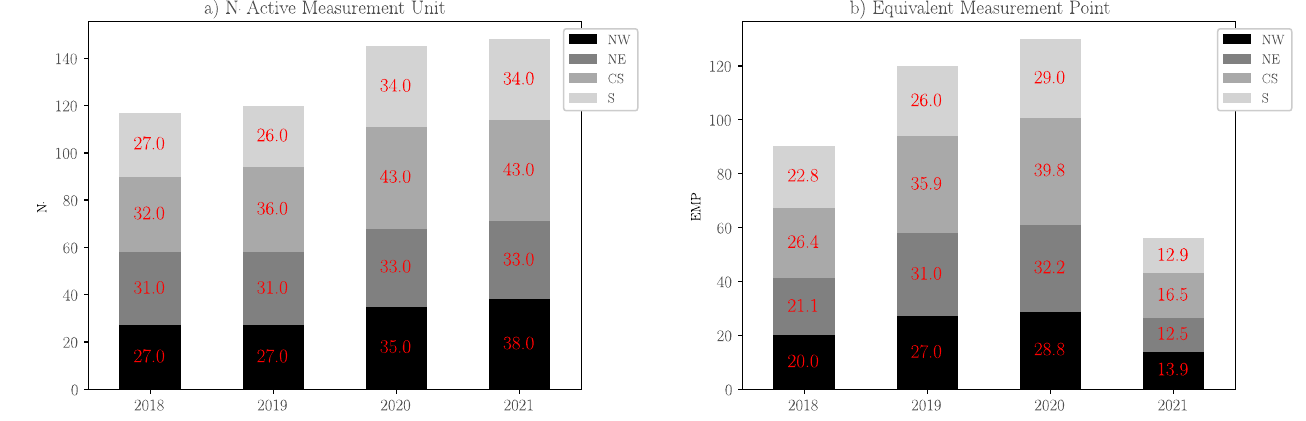
Figure 12. ( a ) number of active MU for each macro-regional area; ( b ) EMP for each macro-regional area.